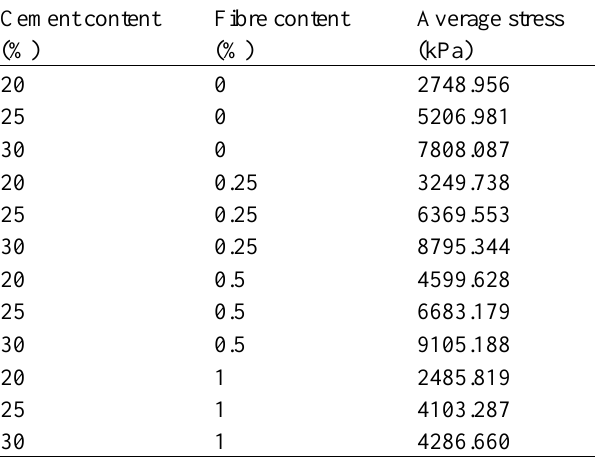
Results of unconfined compressive strength test Cement